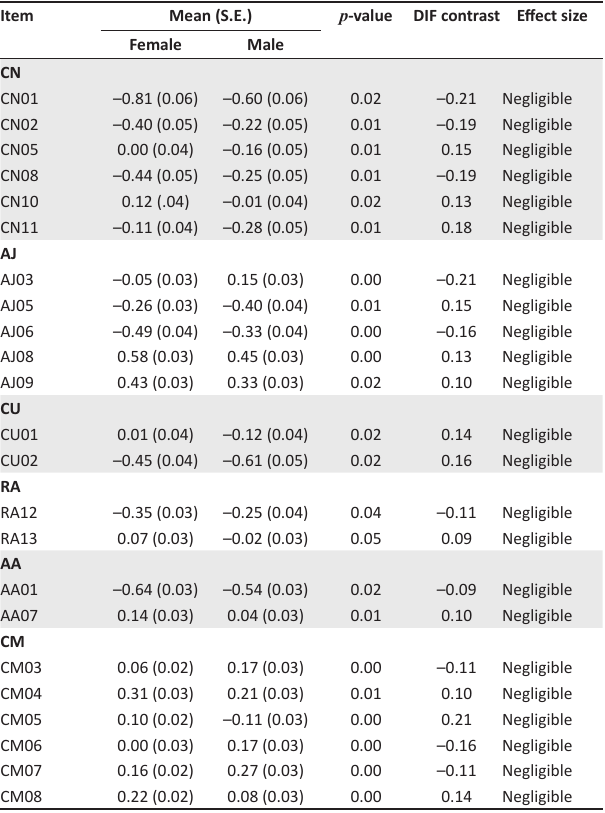
TABLE 5: The DIF between gender groups. Item Mean (S.E.)